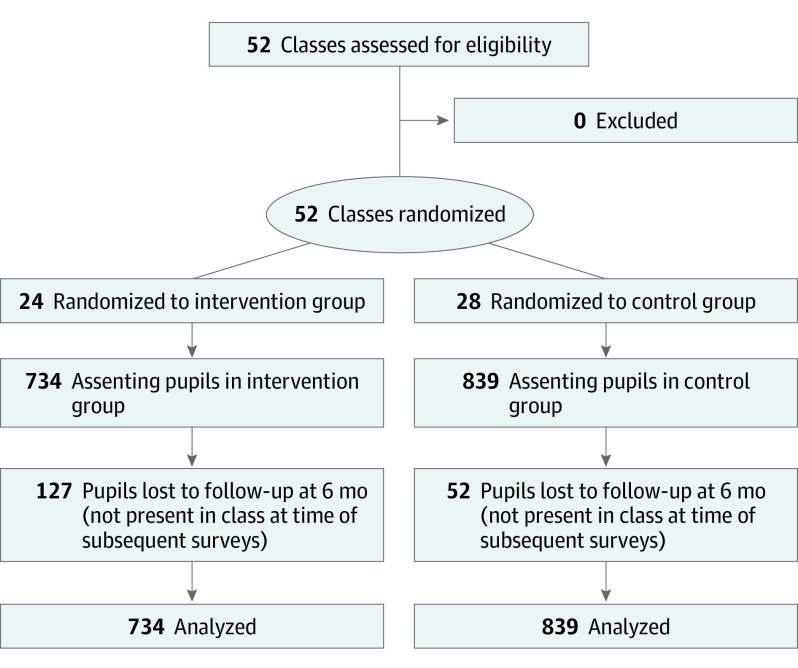
CONSORT Diagram